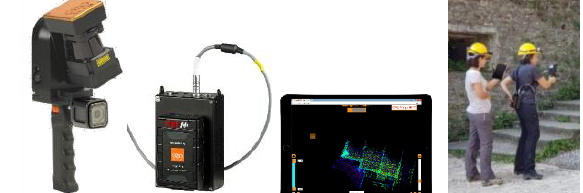
Figure 3. The Zeb REVO RT system and an image of the